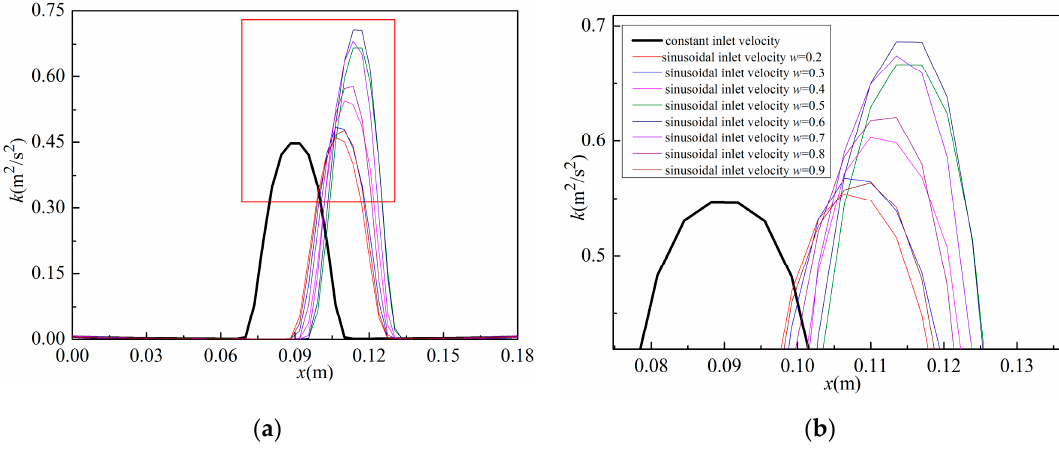
Figure 15. Instantaneous turbulence kinetic energy distribution on the axis of the nozzle in the x -plane by CFD for sinusoidal and constant inlet velocities at u m = 1.25 m/s, T = 0.4, A = 0.25 m/s, L / D = 4 and ∆ ϕ = T /2 during one period. ( a ) entire instantaneous k axial distribution; ( b ) local enlarged detail of Figure 15a.